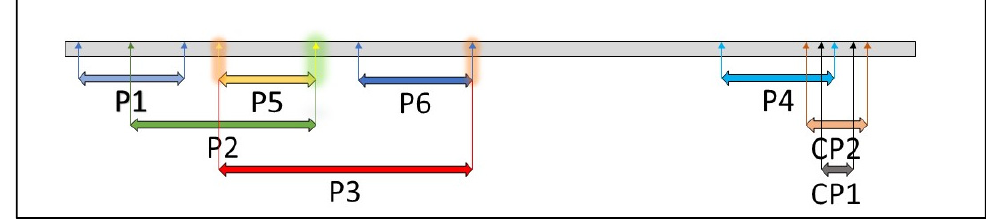
Figure 1. Regions of the ToMV SL-1 genome targeted by primer pairs (Table 1).